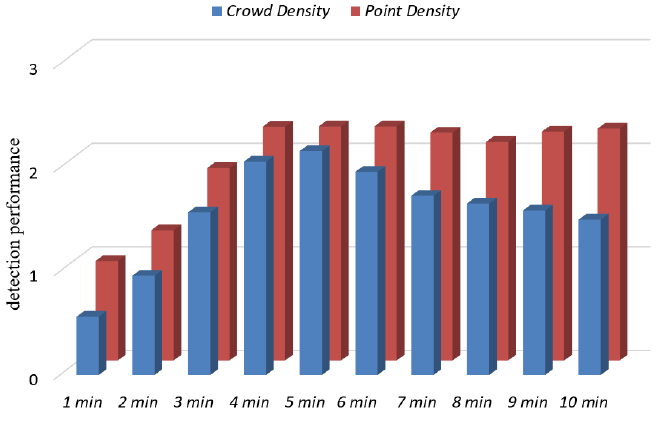
Figure 6. Impact of parameters ( 𝜖 2 ) on IndoorSRC.